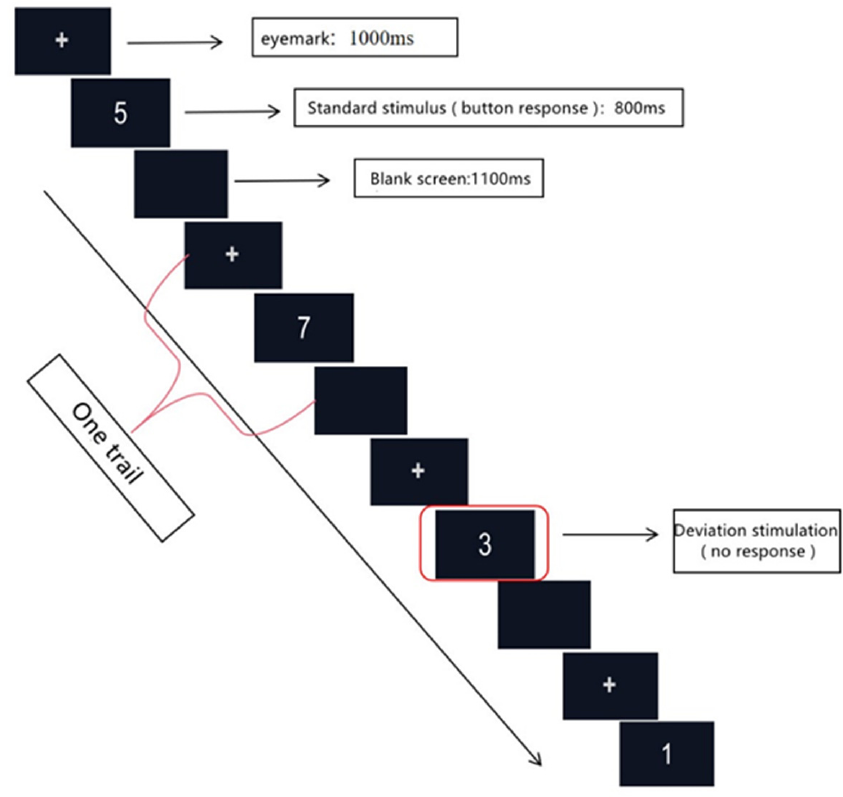
Figure 1. SART paradigm stimulus presentation sequence.